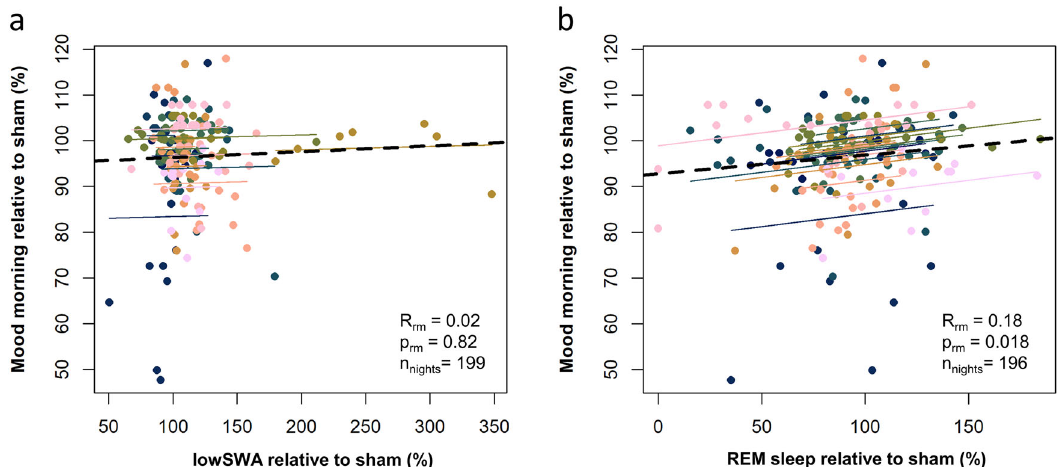
Fig. 5 Repeated measures correlation of mood with low-frequency slow wave activity (lowSWA) and rapid eye movement (REM) sleep. Repeated measures (rm) correlation of ( a ) slow wave activity in the low-frequency range of 0.75 – 1.25 Hz (lowSWA) (calculated using the consecutive analysis (see methods), windows with >2 stimulations) changes in Verum relative to Sham and ( b ) REM sleep changes relative to Sham with mood changes relative to Sham. Mood assessments were used from the morning assessments (lower values indicate a more negative mood). All nights during Verum were taken (pooled approaches in this correlation) relative to the averaged values of the respective Sham period (Sham ONOFF in windowed Verum nights, Sham ON in continuous Verum nights). Data underlying this fi gure is provided in Supplementary Data